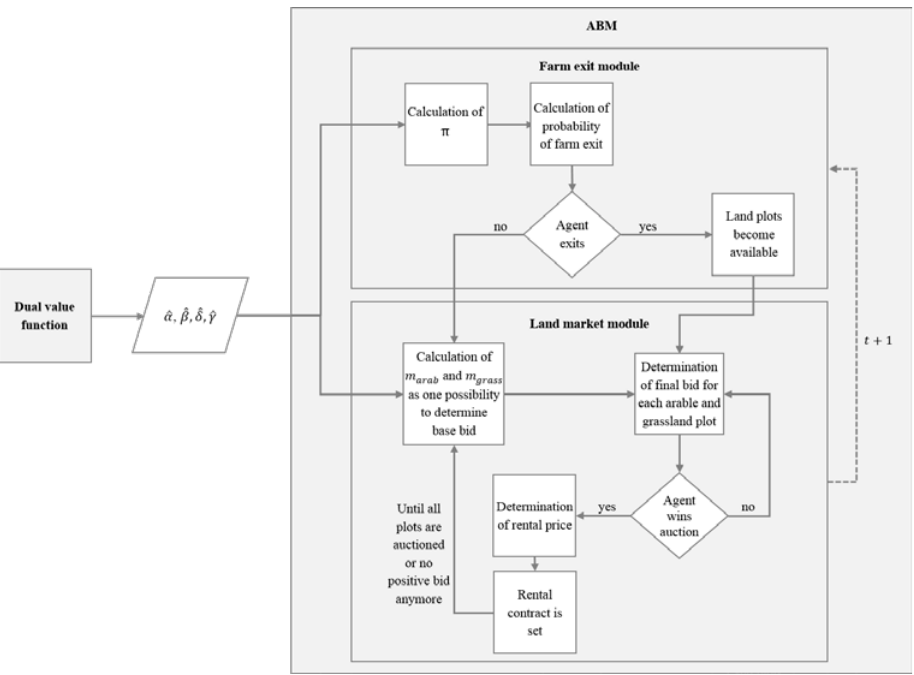
Figure 4. Connection of dual value function and